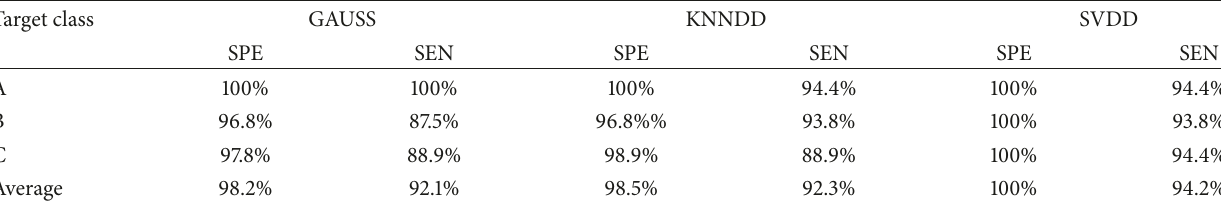
Table 1: Summary of the performance of different models.